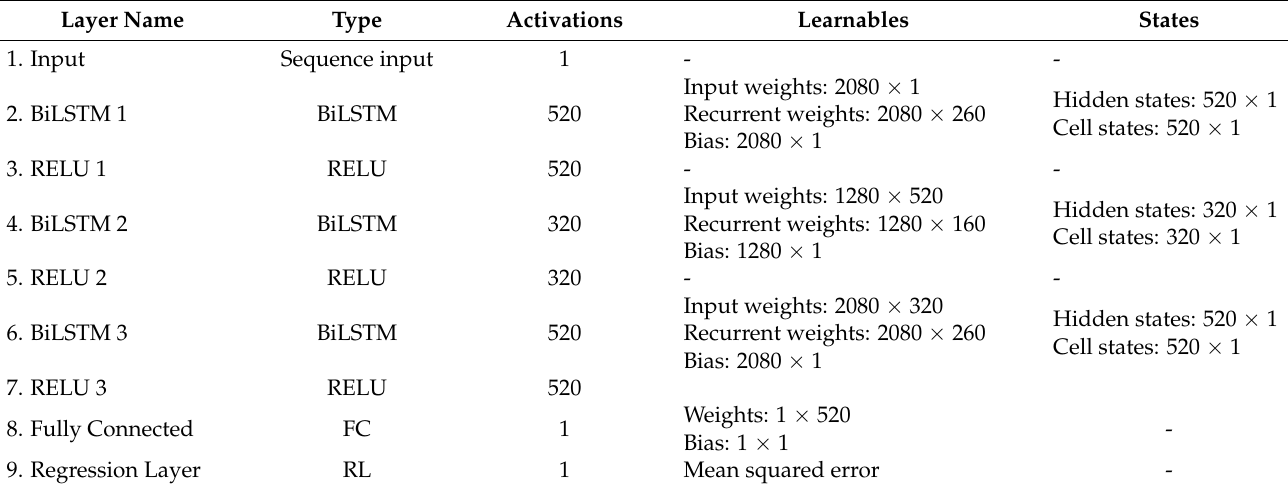
Table 5. Hyperparameters defining the architecture of the LSTM